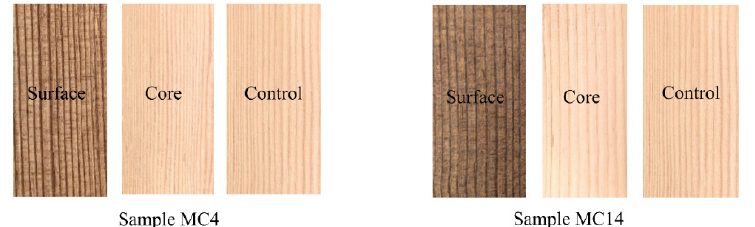
Figure 4. The appearance of the surface layer and the core layer of the heat-treated samples compared to the control sample.